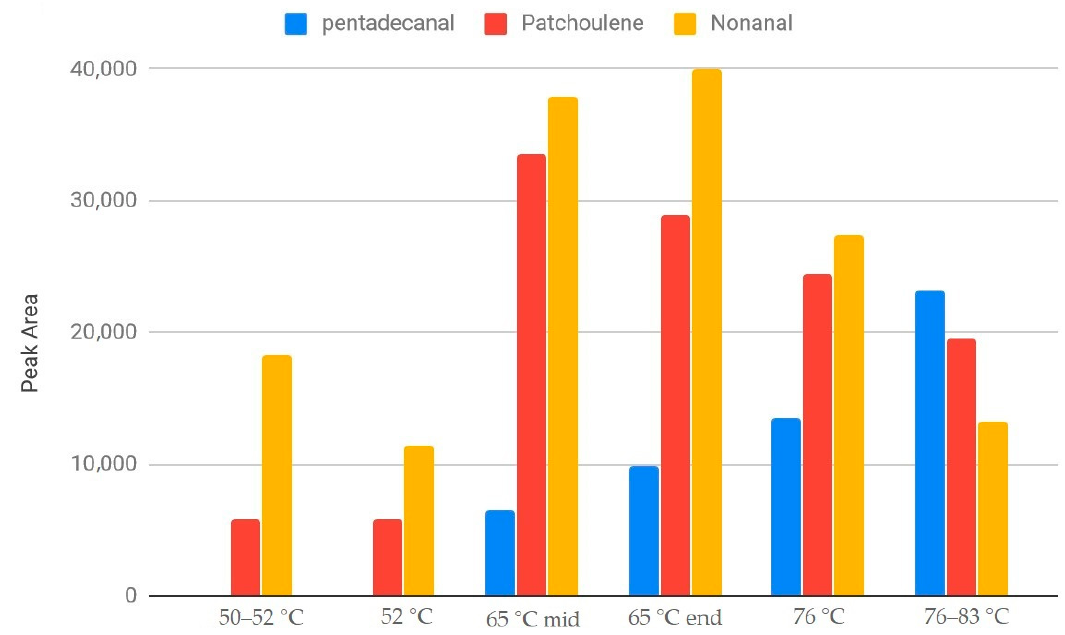
Figure 4. Variation in peak areas of some commonly identified compounds at different temperature stages of malt roasting, i.e., as the temperature was raised from 50 °C to 52 °C, during the 52 °C heating stage, mid-way through the 65 °C heating stage, at the end of the 65 °C heating stage, during the 76 °C heating stage, and as the temperature was increased from 76 °C to 83 °C.